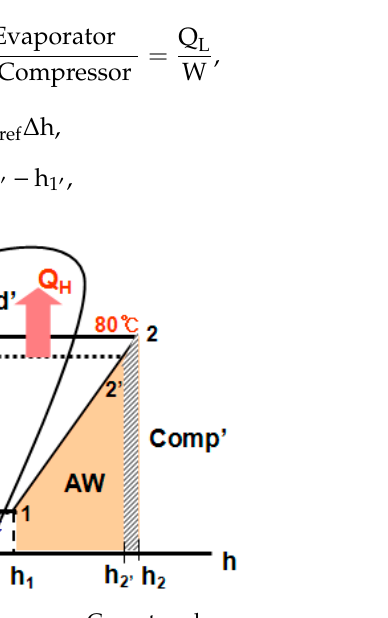
Figure 2. Schematic diagram for the reverse Carnot cycle.